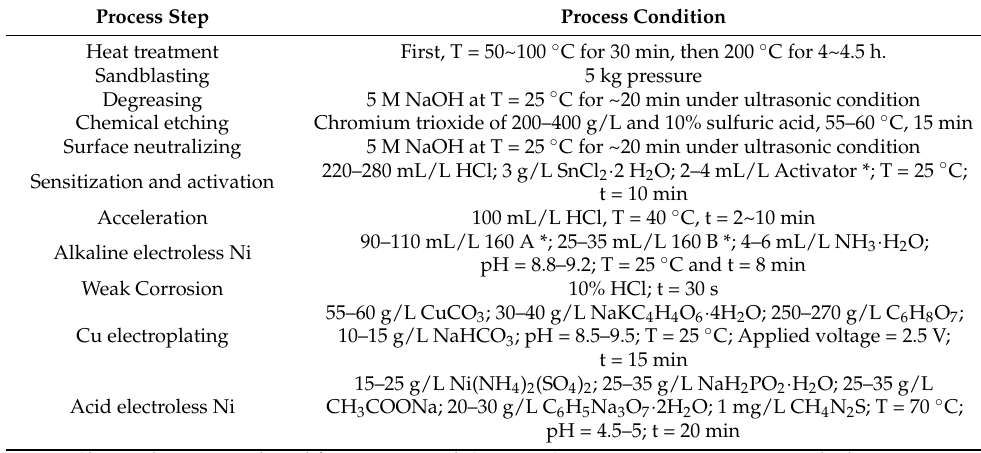
Table 2. Process steps involved in metallization on PEI